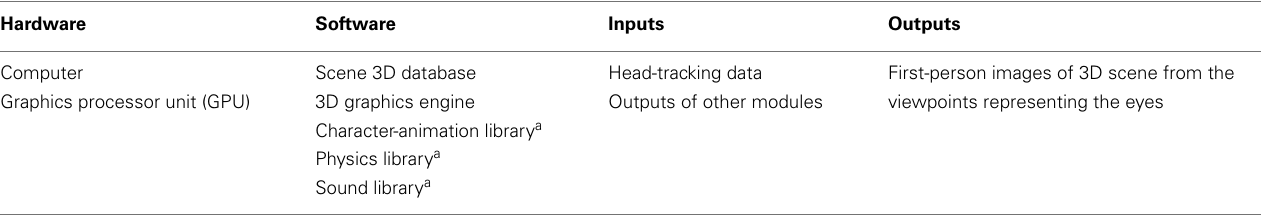
Table 1 | Characteristics of the coreVR module